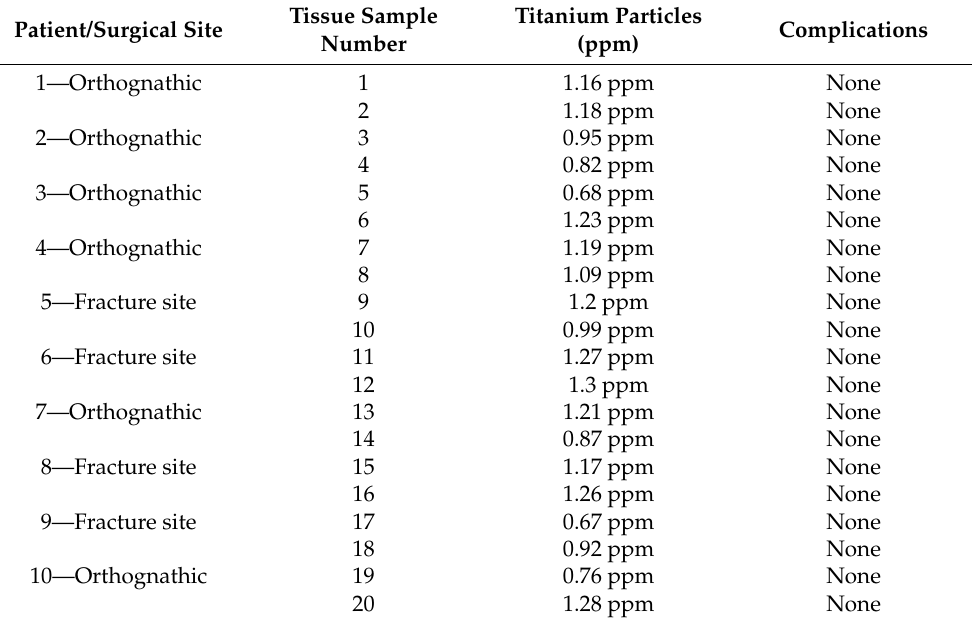
Table 2. Summarized results of the soft tissue samples retrieved adjacent to titanium plates. Patient/Surgical Site